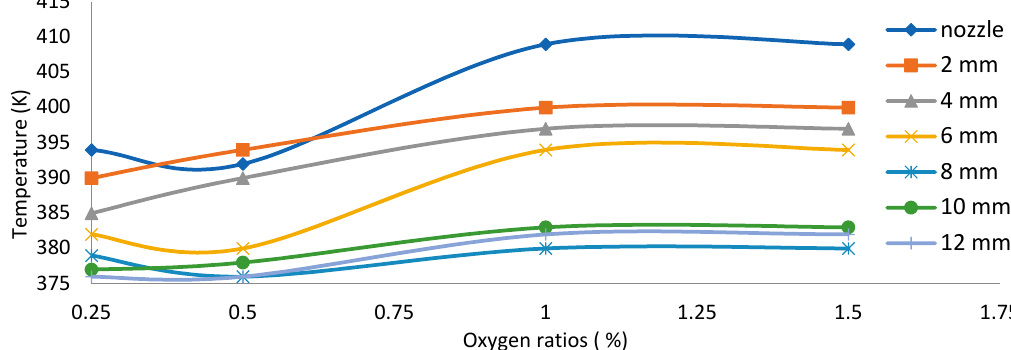
Figure 10. Oxygen ratio (with 1 slm of argon flow rate) vs. temperature of the emerging jet for different axial distributions.